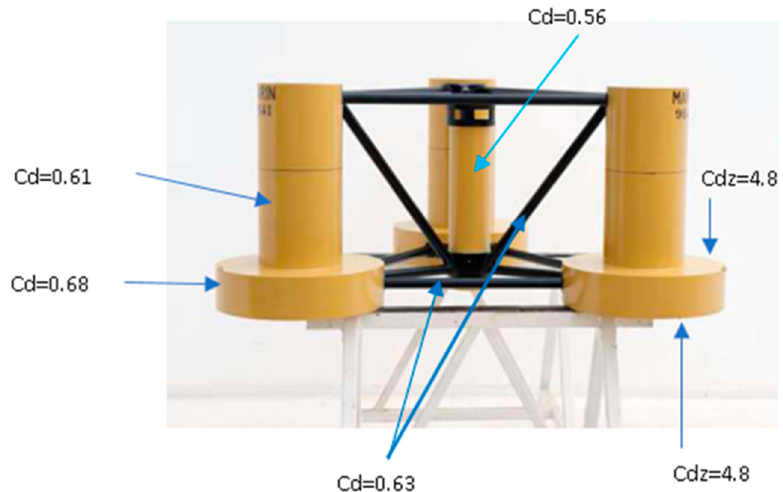
Figure 5. Drag coefficients of OC4 semi-submersible components, where Cd is the drag coefficient in Figure 5. Drag coe ffi cients of OC4 semi-submersible components, where Cd is the drag coe ffi cient in the horizontal direction, and Cdz is the drag coefficient in the vertical direction. the horizontal direction, and Cdz is the drag coe ffi cient in the vertical direction. J. Mar. Sci. Eng. 2020 , 8 , x